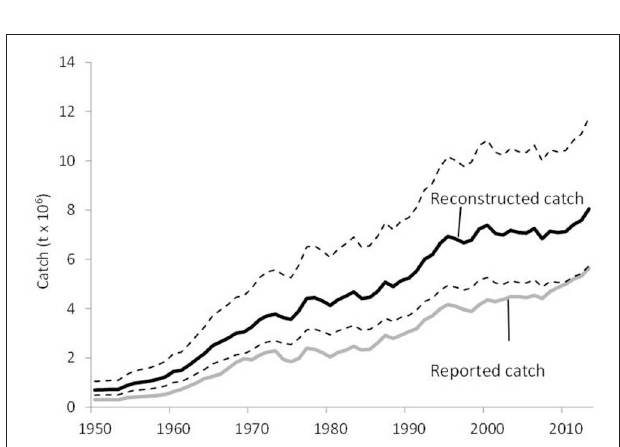
FIGURE 2 | The mean weighted uncertainty (dashed lines) of total reconstructed catch. Uncertainty is based on data quality scores assigned to each country.